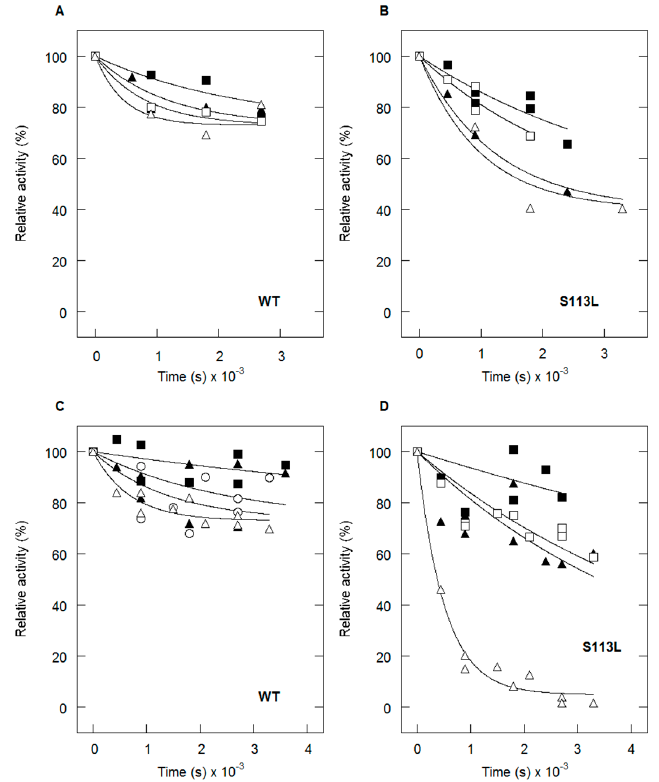
Figure 2. Effect of malonyl-CoA and malonic acid (malonate) on the kinetic stability of recombinant CPT II enzymes. Inactivation of His 6 - N - h CPT2 at different concentrations (squares: 10 µM, triangles: 200 µM inhibitor) and temperatures (closed symbols: activity at 4 °C, open symbols: activity at 30 °C). ( A ) by malonyl-CoA and ( C ) by malonic acid (malonate). Inactivation of His 6 - N - h CPT2/S113L at different concentrations and temperatures ( B ) by malonyl-CoA and ( D ) by malonic acid (malonate). The data is shown as time-dependent change of relative activities.